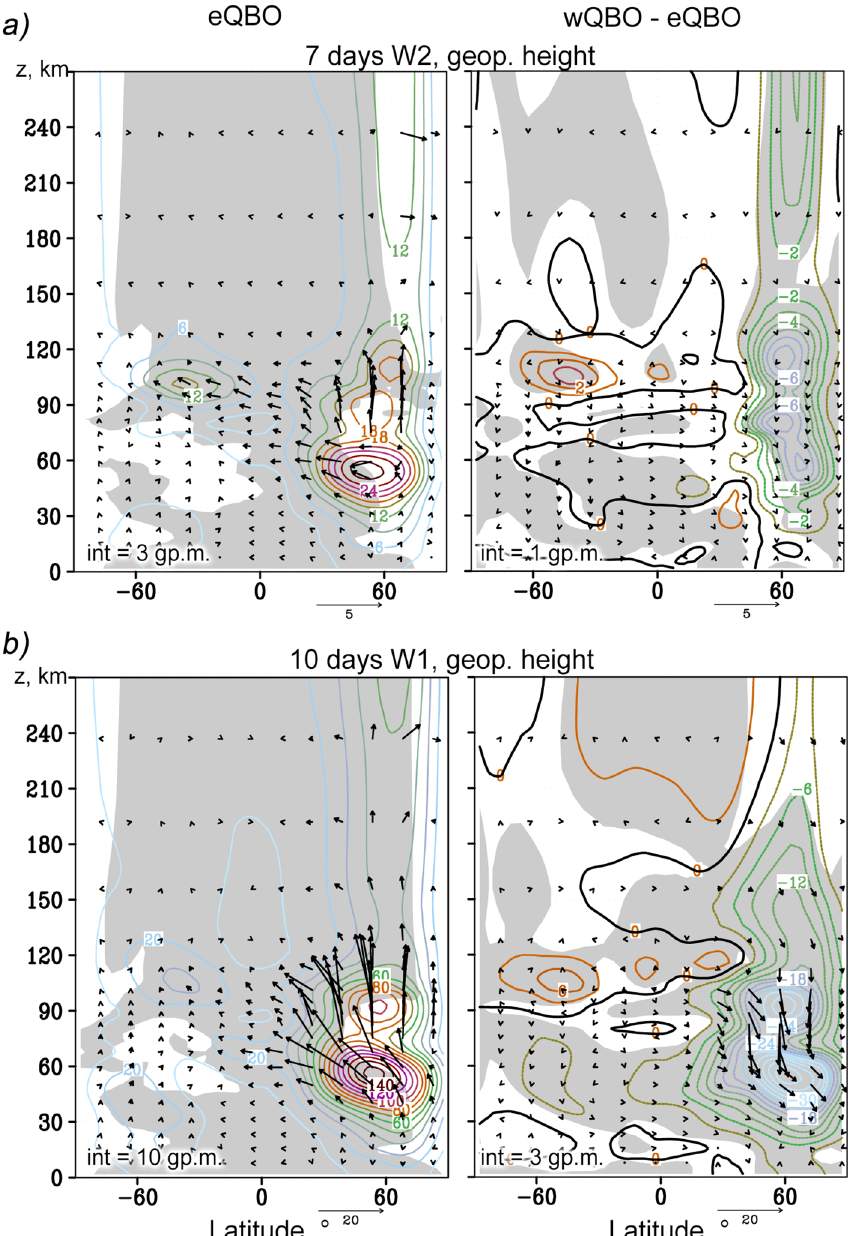
Figure 4. The same as Fig. 2 but for the westward travelling atmospheric NMs: τ = 7 days, m = 2 ( a ); τ = 10 days, m = 1 ( b